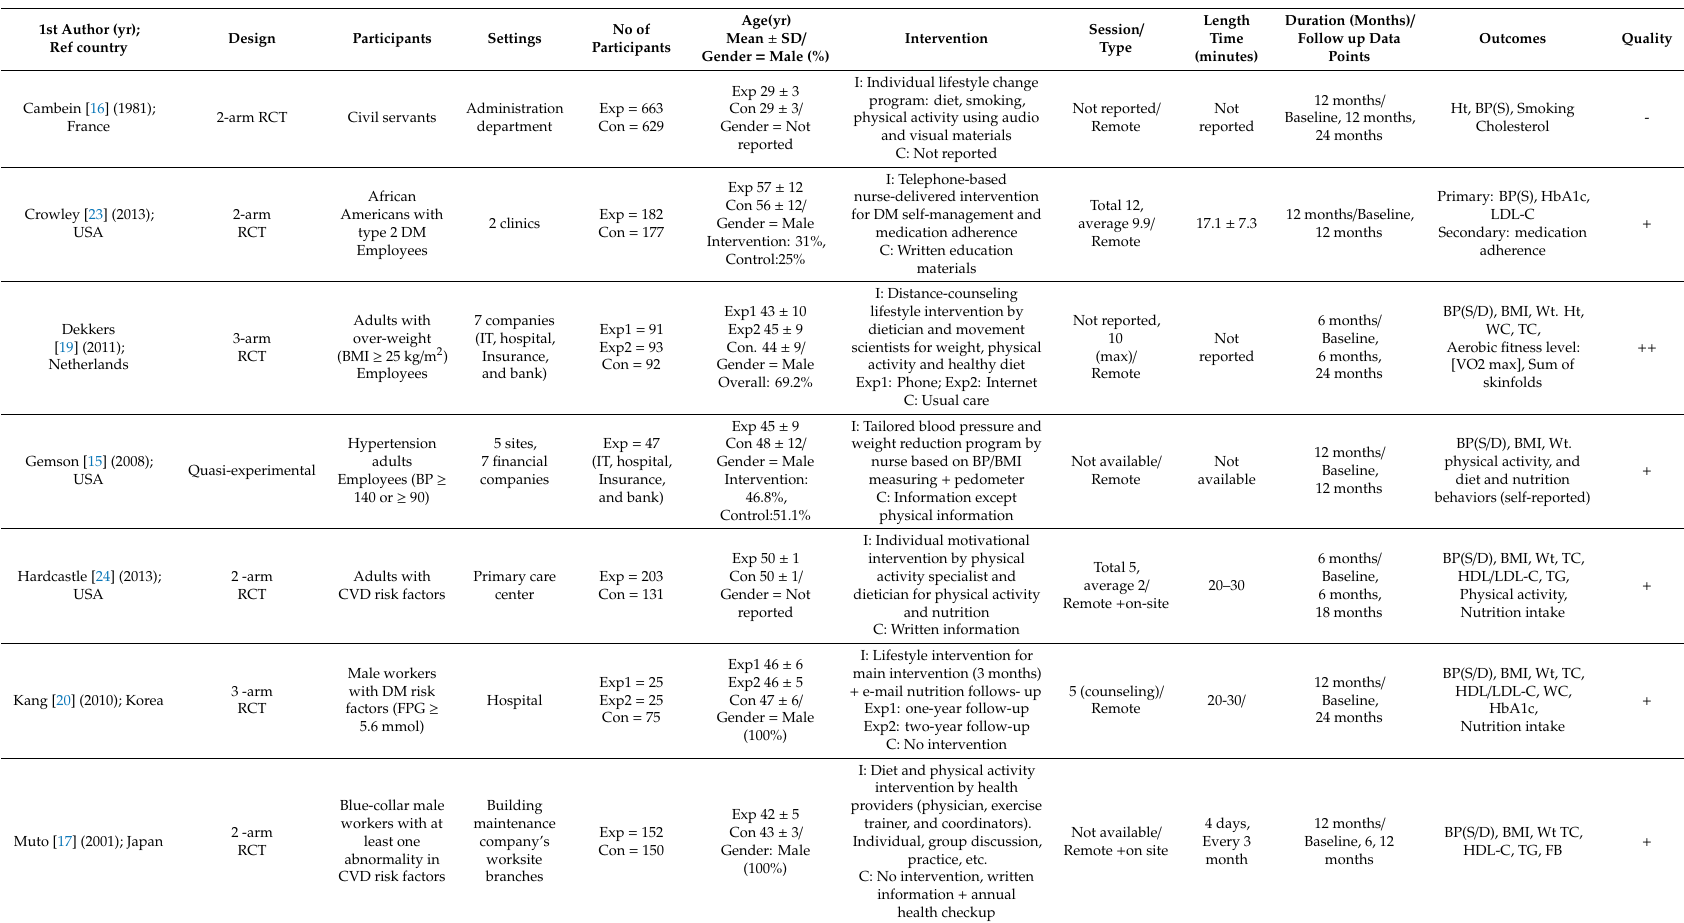
Table 1. General Characteristics of the